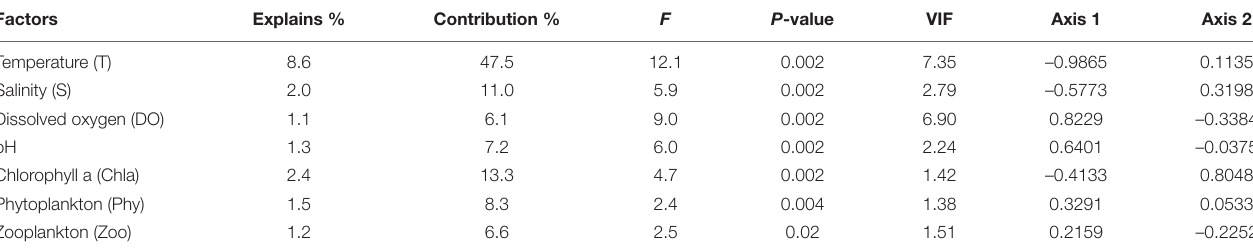
TABLE 3 | Results of Monte Carlo test of F -ratios and the interset correlations of environmental variables with the first two canonical correlation analysis (CCA) axes. Factors